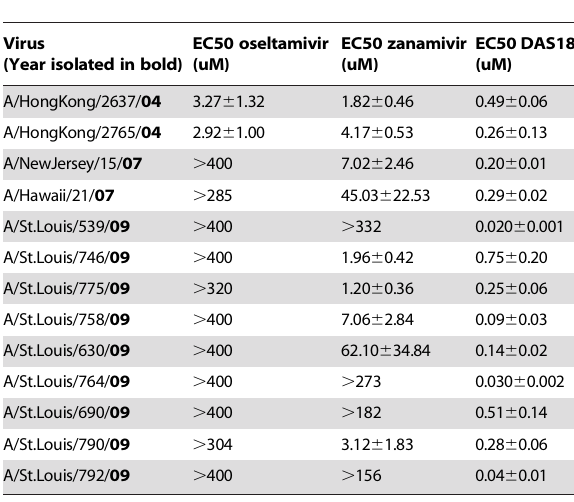
Table 1. In Vitro sensitivity of recent clinical isolates to NAIs and DAS181.